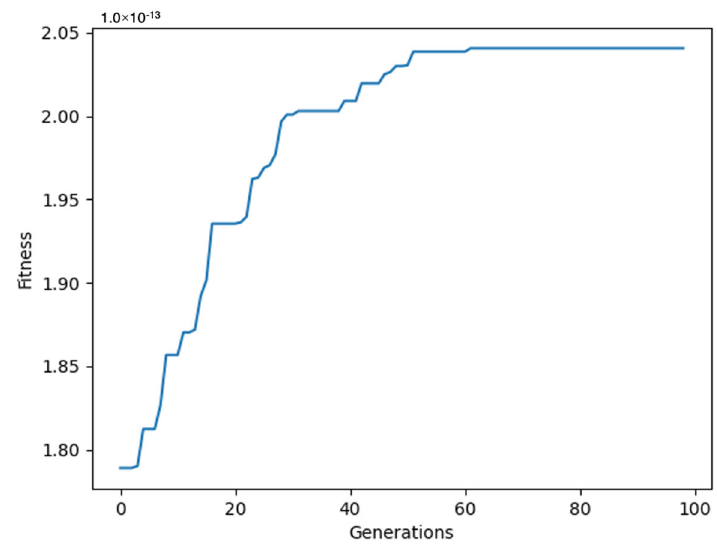
Figure 3. Fitness values for each generation (GA2).